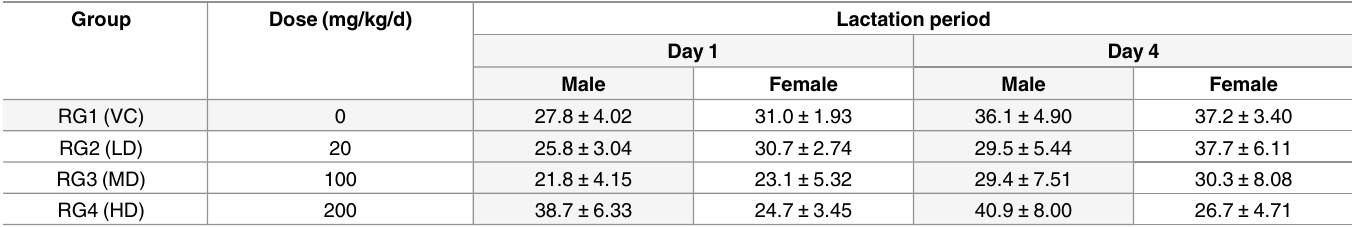
Table 7. Body weight of male and female pups (in g) during lactation in reproductive/developmental toxicity study of 3’-HPT in Wistar rats. Group